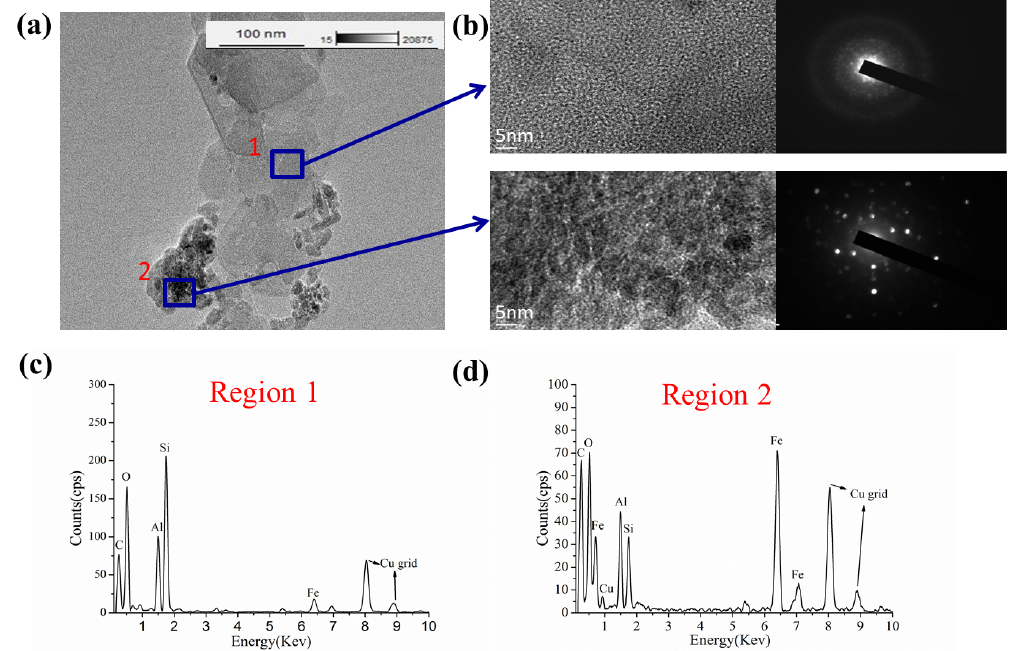
Figure 1. High-resolution transmission electron microscopy (HRTEM) images of highly reactive minerals in colloids extracted from soil (Ferralic Cambisol) after 24-year long-term (1990–2014) NPKM fertilization. (a) TEM images; (b) HRTEM images and selected area electron diffraction (SAED) patterns of the two regions indicated by the blue squares, showing that the black region is a complete crystalline, while the grey region is amorphous; (c–d) energy-dispersive X-ray analysis (EDX) images of the region 1 and region 2. NPKM, chemical NPK plus swine manure fertilization. Also see Fig. S2 for similar HRTEM images under the control and NPK